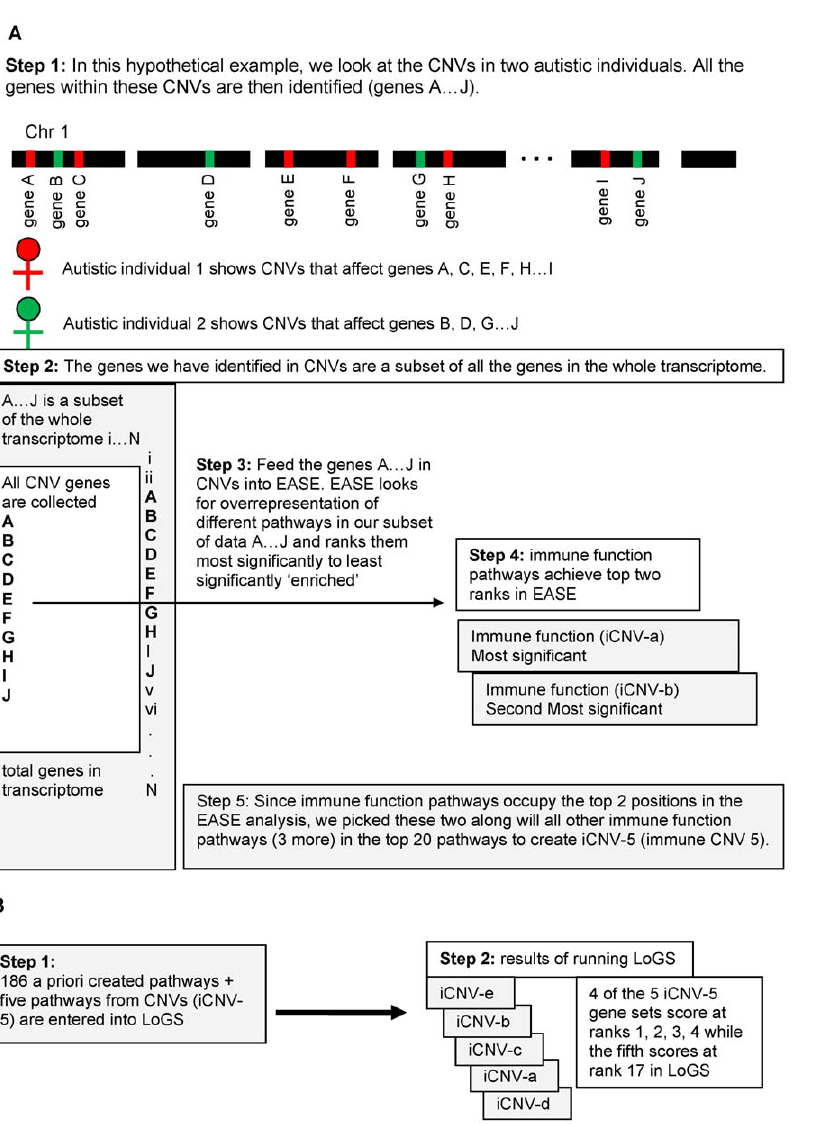
Figure 2. Overall analysis scheme. All genes within CNVs were used to find the top ranked pathways in the CNVs (A) and these new pathways along with other a priori created pathways were tested using LoGS (B).